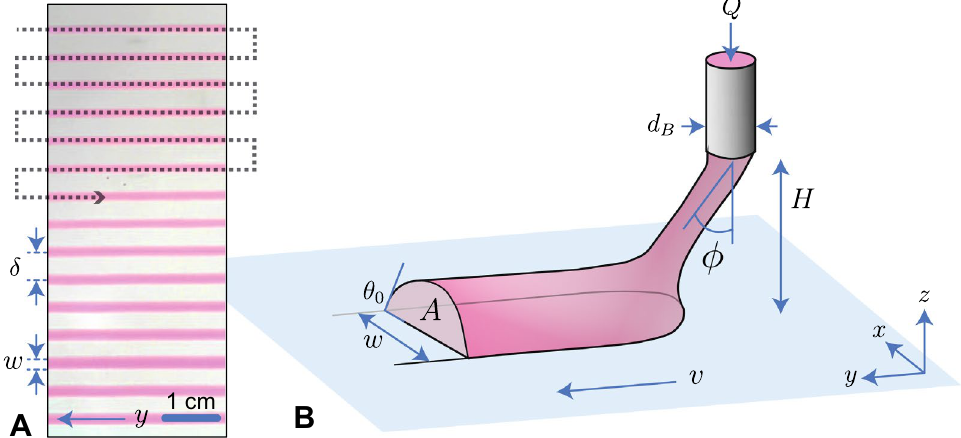
Figure 1. ( A ) The serpentine pathway highlighted with the dotted line permits us to evidence some specific writing regimes, here for instance the continuous regime where well defined straight lines are deposited and whose widths may be controlled during the deposition. ( B ) Realistic sketch of the deposition front which connects the fluid extruded from the injection nozzle to the deposited line on the bed. The writing parameters Q and v along with the wettability of the fluid onto the bed and its visco-elasto-plastic properties get combined to determine the morphology of the written line. The figure was created with Adobe Illustrator v27.1, see https:// www. adobe. com/ fr/ produ cts/ illus trator. html.